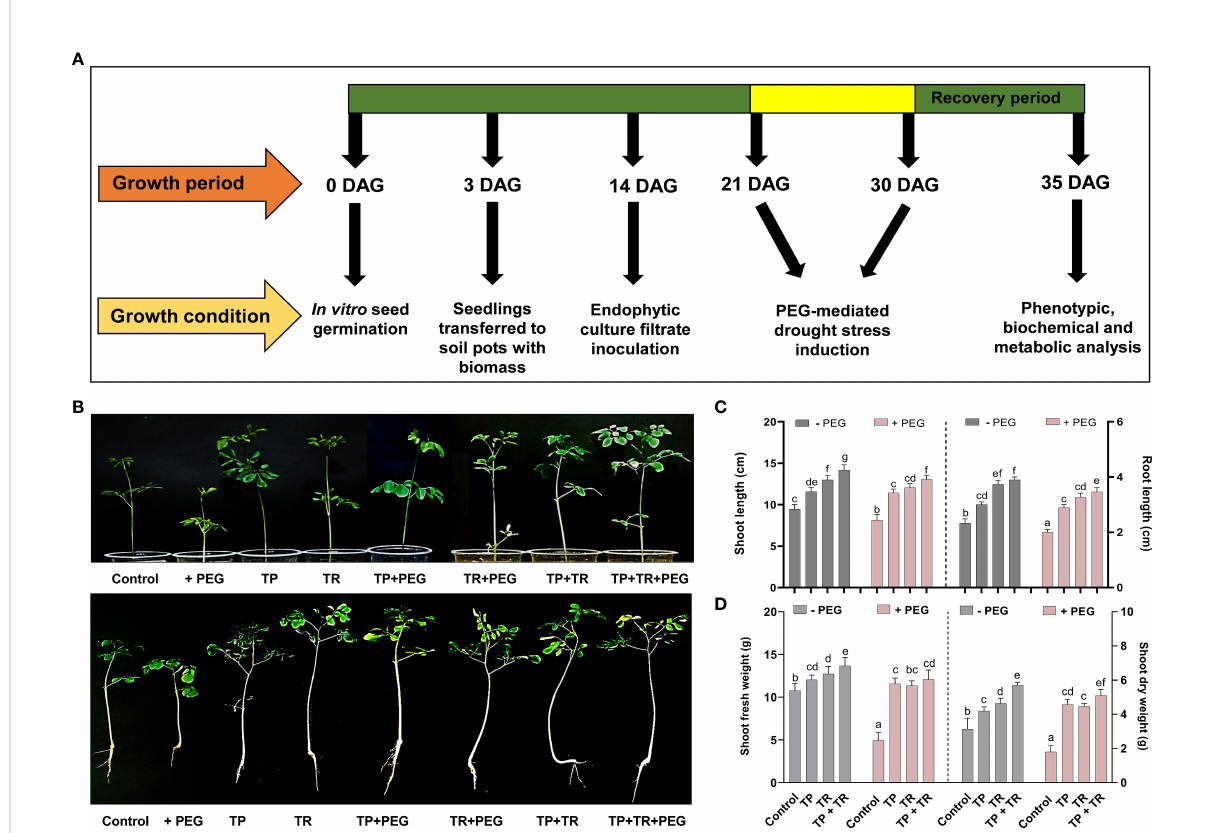
FIGURE 5 Effect of TP and TR inoculation on M. oleifera plant growth. (A) Schematic representation showing work plan of plant bioassay, (B) Phenotypic analysis; upper penal (intact plants) and lower penal (uproots plants), (C) Shoot and root length, (D) Total fresh and dry weight. Quantitative data is representing the means ± SE values of at least three independent biological replications. Various letters have been presented to show the statistical differences at signi fi cance level of p¾ 0.05 using Duncan ’ s Multiple Range Test